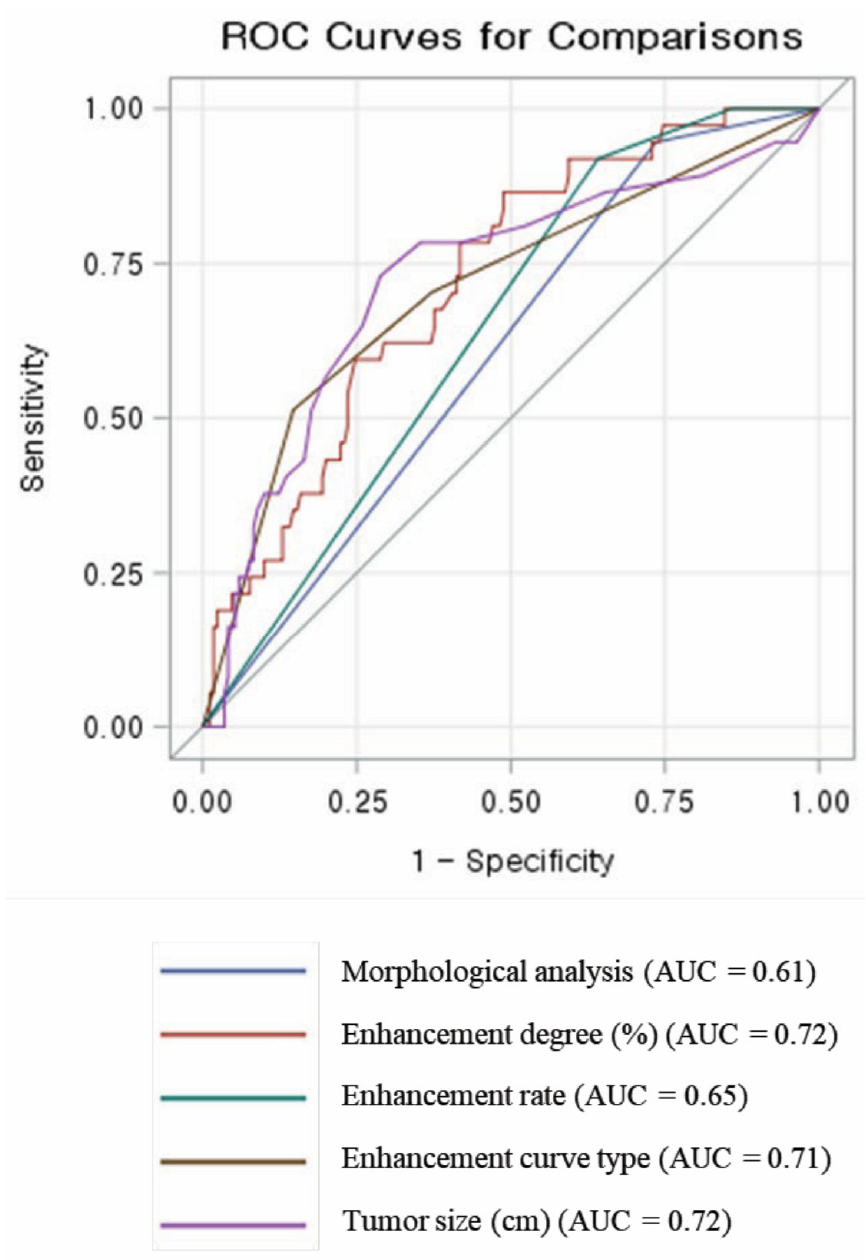
Figure 3. ROC curves of the parameters for detecting invasive cancer. ROC = receiver operating